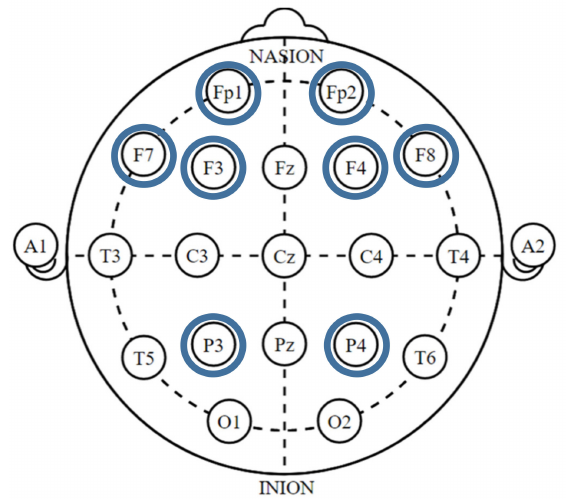
Figure 2. Selected electrodes for the electroencephalogram (EEG) analysis (International 10–20